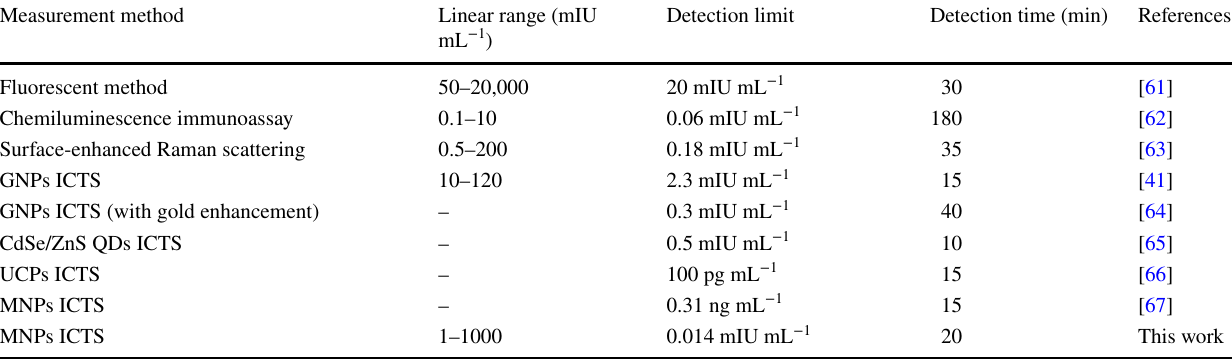
Table 2 Comparison of different detection methods for